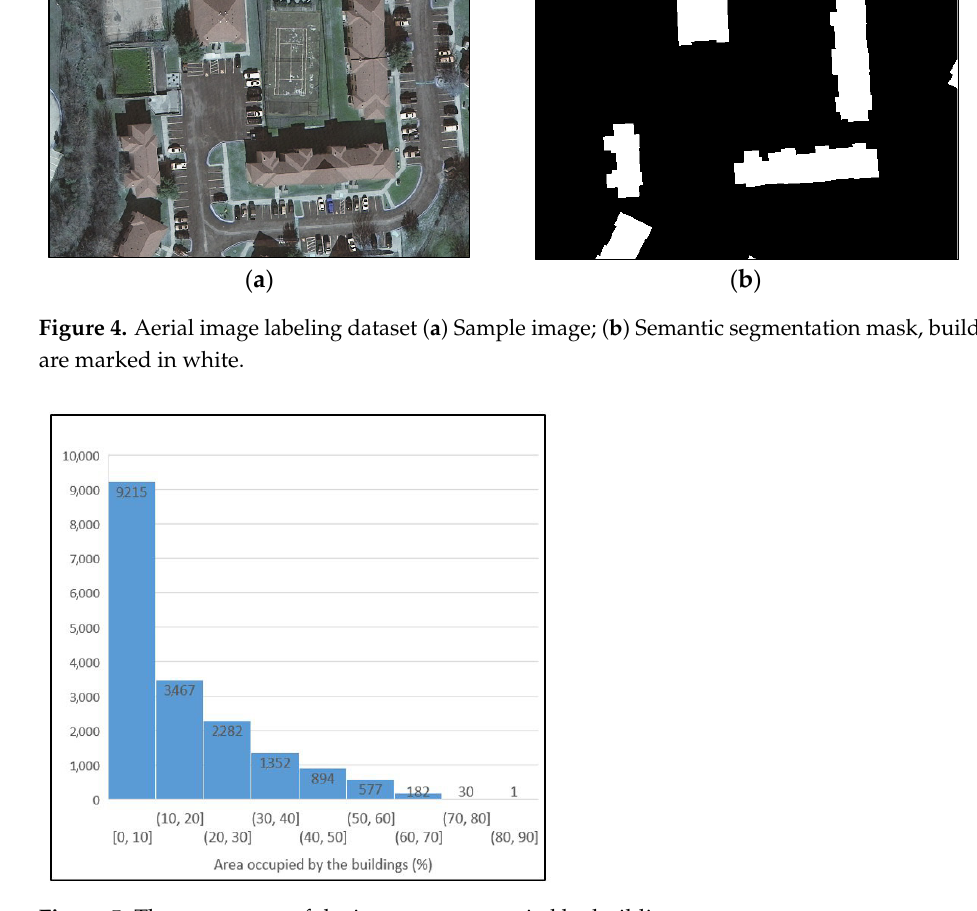
Figure 5. The percentage of the image area occupied by buildings.